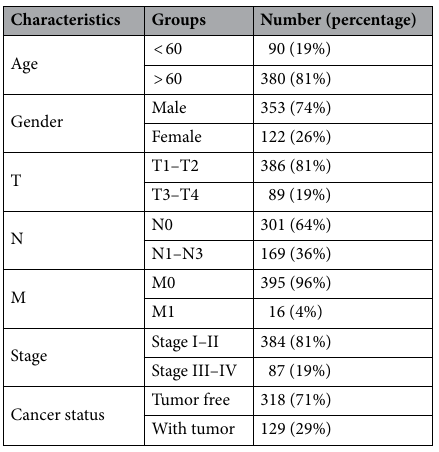
Table 1. Clinical characteristics of the TCGA